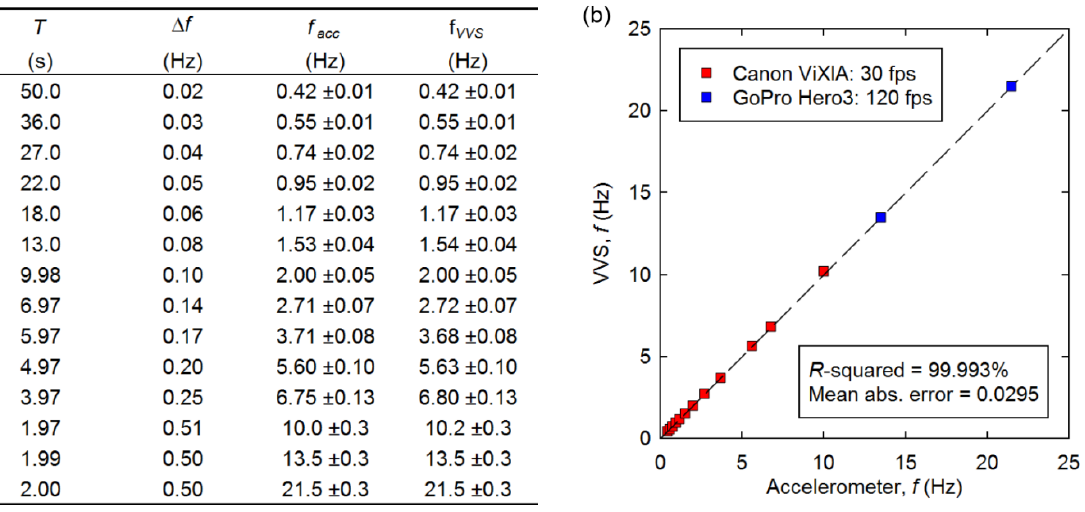
Figure 6. ( a ) Table and ( b ) plot showing correlation between physical accelerometer and virtual visual sensor